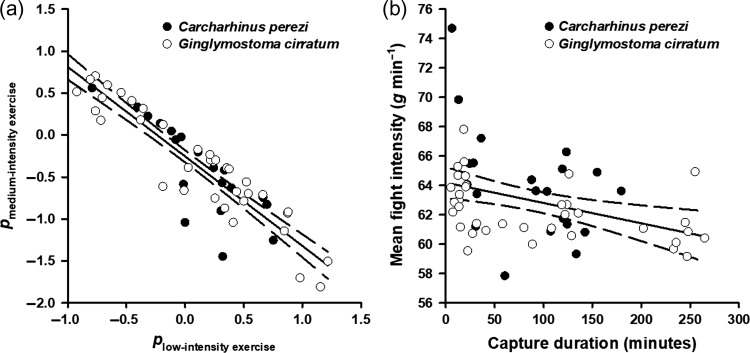
Correlations between possible explanatory exercise metrics. Proportions (a) of the total capture event when sharks exhibited low- (plow-intensity exercise) and medium-intensity (pmedium-intensity exercise) exercises were correlated (Linear regression, R2 = 0.84, F1, 55 = 290.96, P < 0.001) and are presented as log-ratio transformed proportions. Mean fight intensity (b; in g min−1 where g = 9.81 m s−2) is measured as the sum of acceleration values recorded during a capture event divided by capture duration and had a negative linear relationship with capture duration (Linear regression, R2 = 0.14, F1, 55 = 9.54, P = 0.003). Data are pooled for nurse sharks (Ginglymostoma cirratum) and Caribbean reef sharks (Carcharhinus perezi).